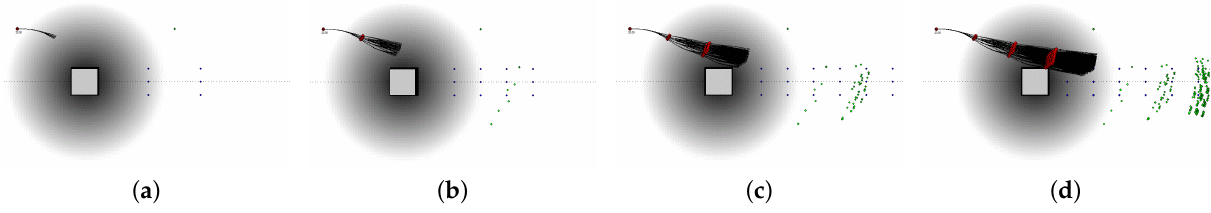
Figure 8. Obstacle avoidance example 3: Moving object represented in distant time frames. The grid maps, and the expansion trees, belong to the same set of maps. The grid maps represent the environment at time T = T 0 + ( h − 1 ) · 600 ms, with the height of the expansion tree equal to h ∈ [ 1,4 ] , i.e., T = T 0 for ( a ), T = T 0 + 600 ms for ( b ), T = T 0 + 2 · 600 ms for ( c ), and T = T 0 + 3 · 600 ms for ( d